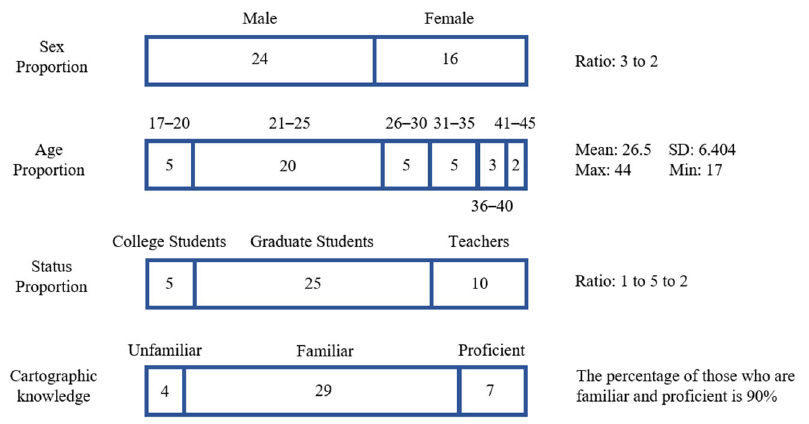
Figure 4. Details of the